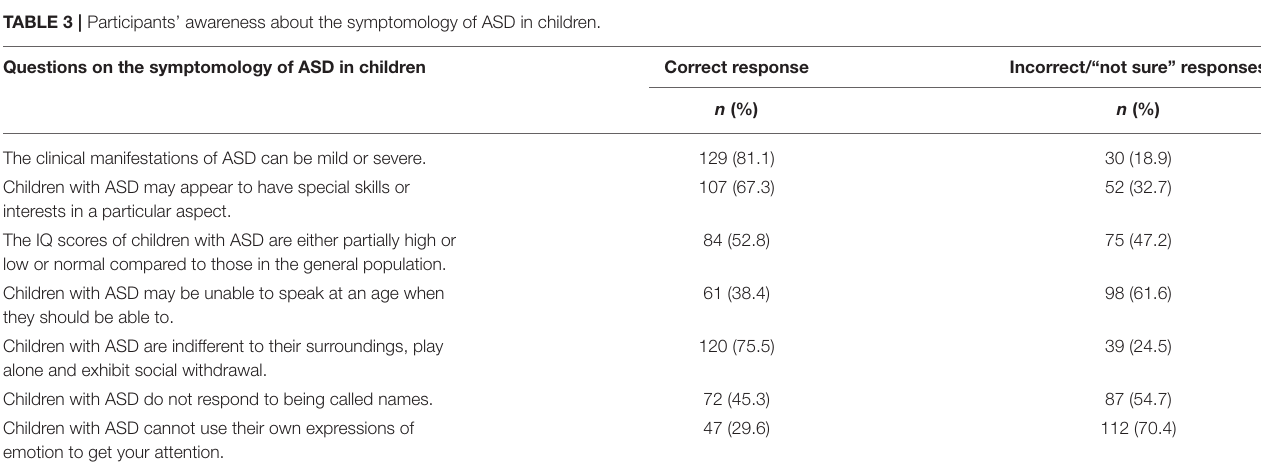
TABLE 3 | Participants’ awareness about the symptomology of ASD in children. Questions on the symptomology of ASD in